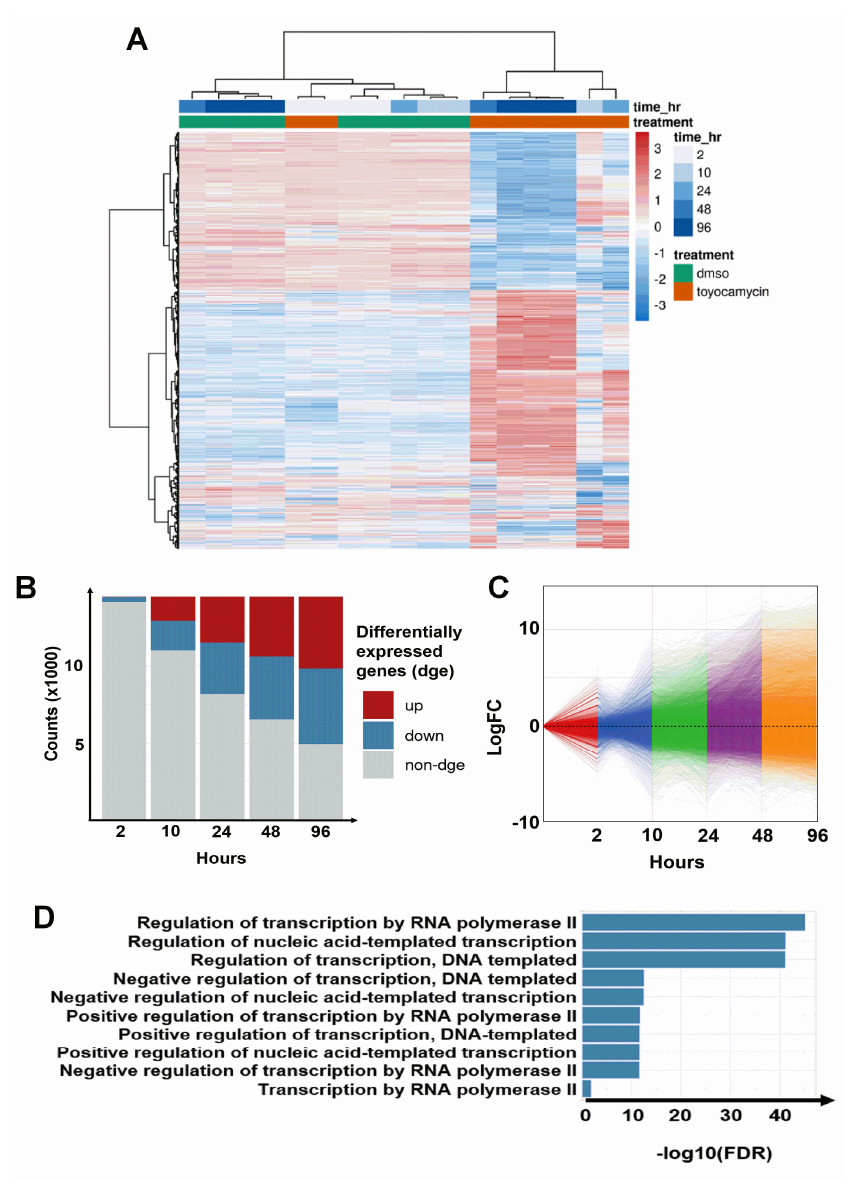
Figure 2. Toyocamycin induces potent time-dependent gene expression changes. YB5 cells were treated with toyocamycin (250 nM) during 2, 10, 24, 48, and 96 h prior to RNA-seq. ( A ) Heatmap showing gene expression log2 fold change (blue-red scale) between toyocamycin-treated and un- treated groups (16,535 genes are shown on the heatmap). The time points at 2 and 10 h are done in duplicates. The time points at 96 h have been done in triplicates and the 24/48 h of treatment have been done with only one replicate. ( B ) Number of differentially expressed genes (upregulated in red and downregulated in blue, unchanged expression is depicted in grey). After 2 h toyocamycin treatment, 513 genes were downregulated and 24 genes were upregulated. After 10 h toyocamycin treatment, 2299 genes were downregulated and 1999 genes were upregulated. After 24 h toyocamycin treatment, 3651 genes were downregulated and 3387 genes were upregulated. After 48 h toyocamycin treatment, 4377 genes were downregulated and 4449 genes were upregulated. After 96 h toyocamycin treatment, 5061 genes were downregulated and 5050 genes were upregulated. ( C ) Gene expression variation over time during toyocamycin treatment. ( D ) Gene enrichment analysis showing RNA regulatory pathways that are downregulated after toyocamycin treatment (2